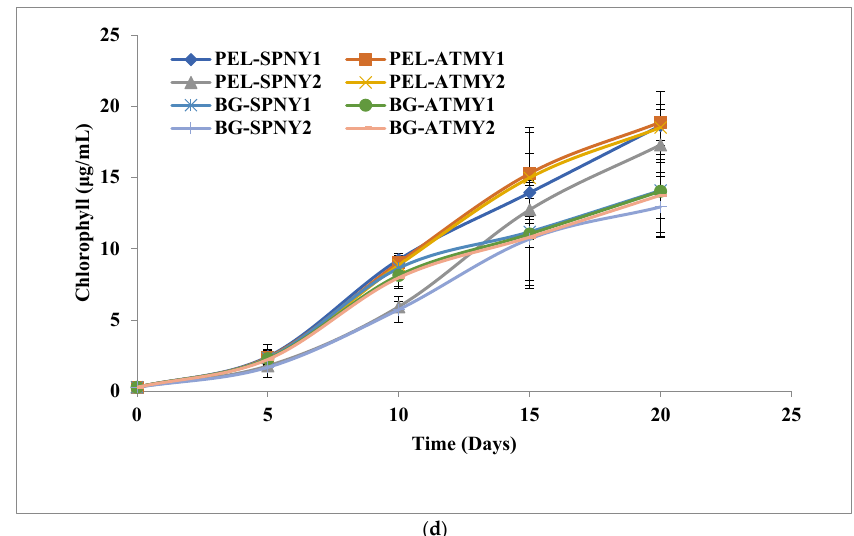
Figure 7. Biomolecules growth of C. pyrenoidosa at solar inclination angles of 47.9°: ( a ) carbohydrates; ( b ) protein; ( c ) lipid; ( d ) chlorophyll.